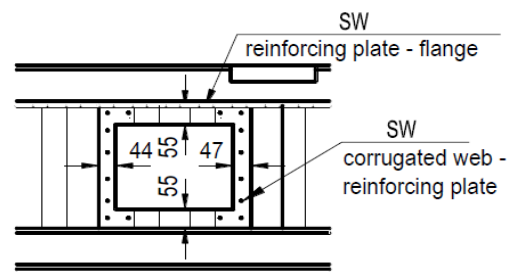
Figure 3. Reinforcing the opening of the web.